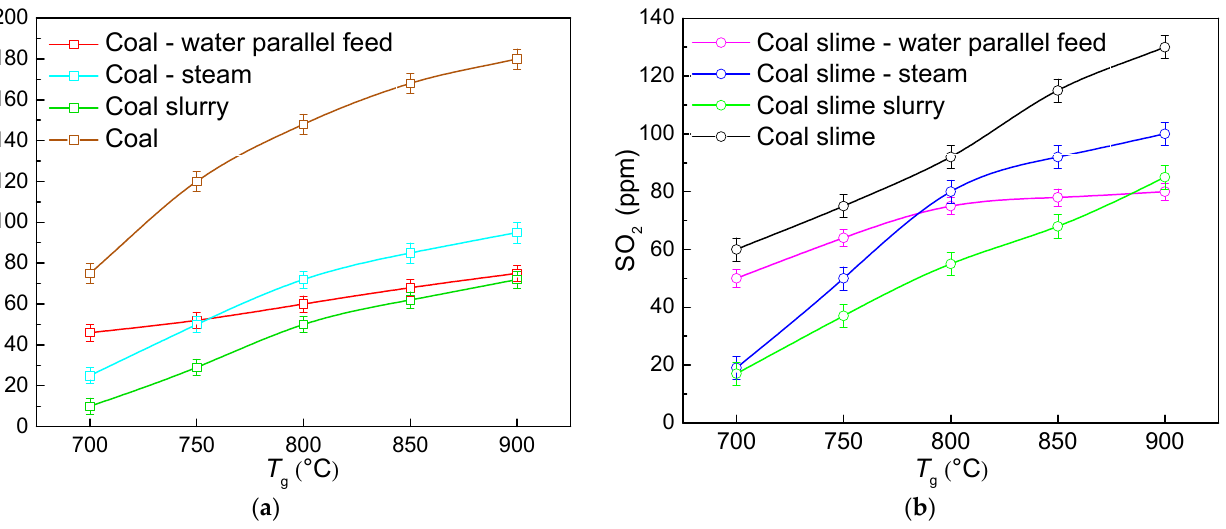
Figure 12. Average concentrations of sulfur oxide when varying the method of introducing the coal component (coal ( a ) and coal slime ( b )) and water, as well as the temperature in the combustion chamber.